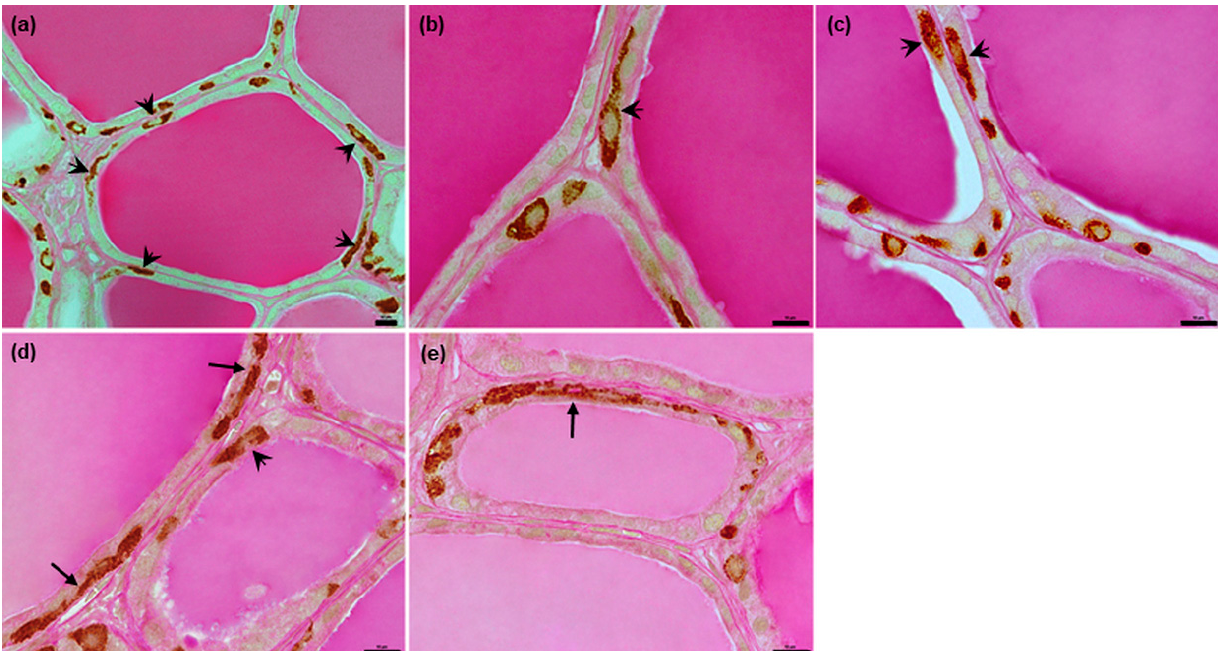
Figure 6. Representative images of porcine C thyrocytes position in relation to the follicular wall. ( a – e ): All C thyrocytes lie exclusively in the intrafollicular position. They are scattered irregularly around the follicle perimeter, separately or in “chains” (arrows), and are visible in both longitudinal (arrowheads) and transverse sections. Combined anti-calcitonin antibody immunohistochemistry– periodic acid Schiff method, scale bars: ( a – e ) = 10 µm.